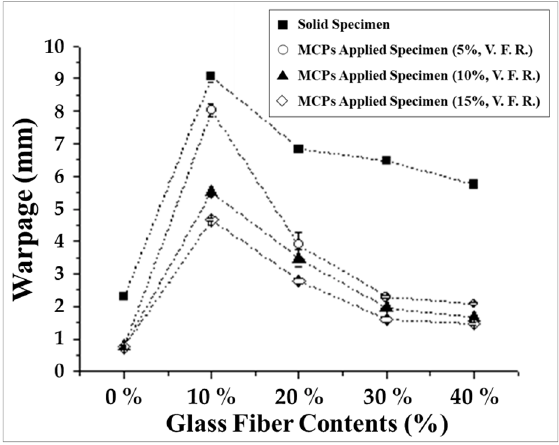
Figure 3. Warpage of microcellular foaming process (MCP)-applied glass fiber reinforced plastics.